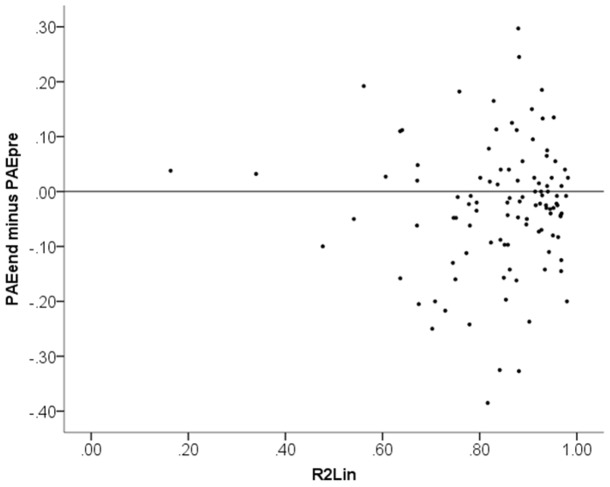
Scatter plot of change in performance from the first session to the end of training (PAEend−PAEpre) plotted against linearity of numerical magnitude representation (R
2
Lin).